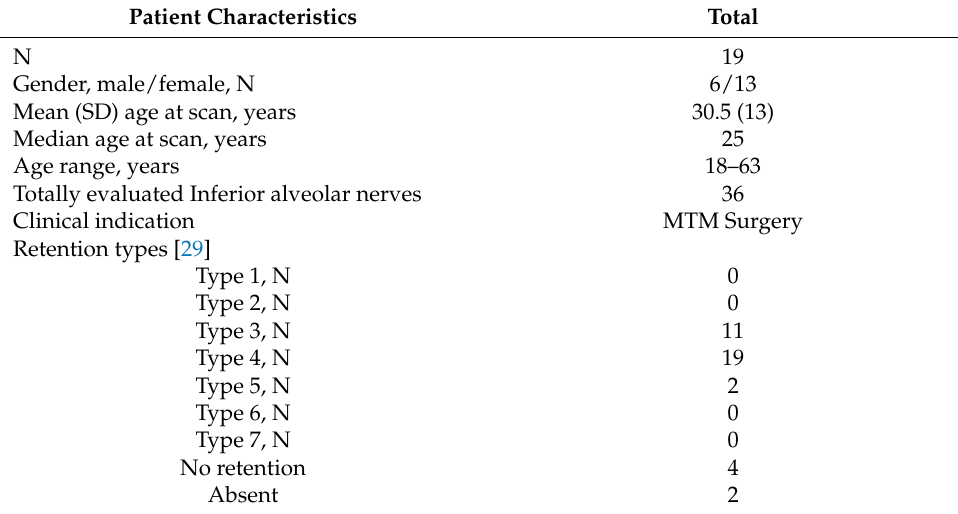
Table 1. Patient